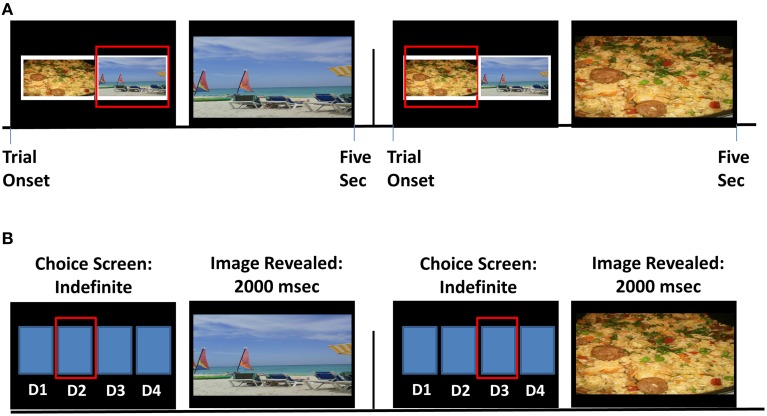
Task schematics of the explicit and probabilistic food choice tasks. (A) The explicit task included training and one block, consisting of 70 trials. Two sample trials are displayed. Continuous button pressing for a given image (indicated by the red box) enlarged the corresponding image, for the 5-s trial duration; no response (for 0.5 s) after initial response returned the side-by-side display. (B) The probabilistic task included training and four task runs. In each trial within a run, participants pressed one of four buttons corresponding to their chosen deck (D1, D2, D3, or D4; also indicated by the red box).